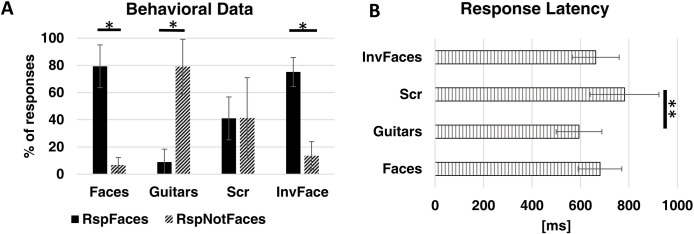
Behavioral results.A) Percentage of responses per stimuli category. *difference between responses per category with p = 0.028. B) Reaction time per stimuli condition. ** p = 0.007. Bars show the group average ± SD (N = 6).